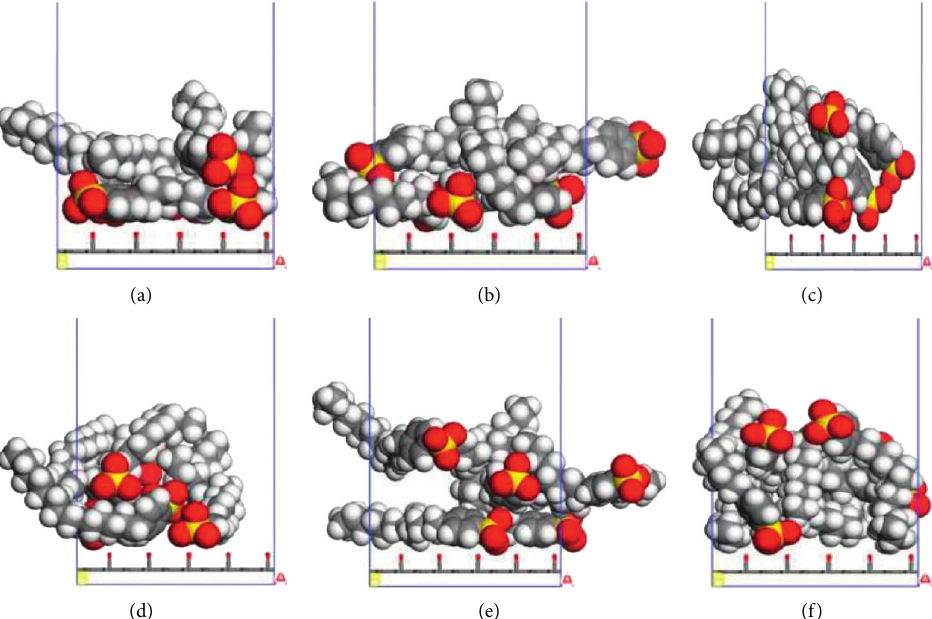
Figure 7: The final configuration of different systems adsorbed near the ketone group: (a) C8; (b) C10; (c) C12; (d) C14; (e) C16; (f)